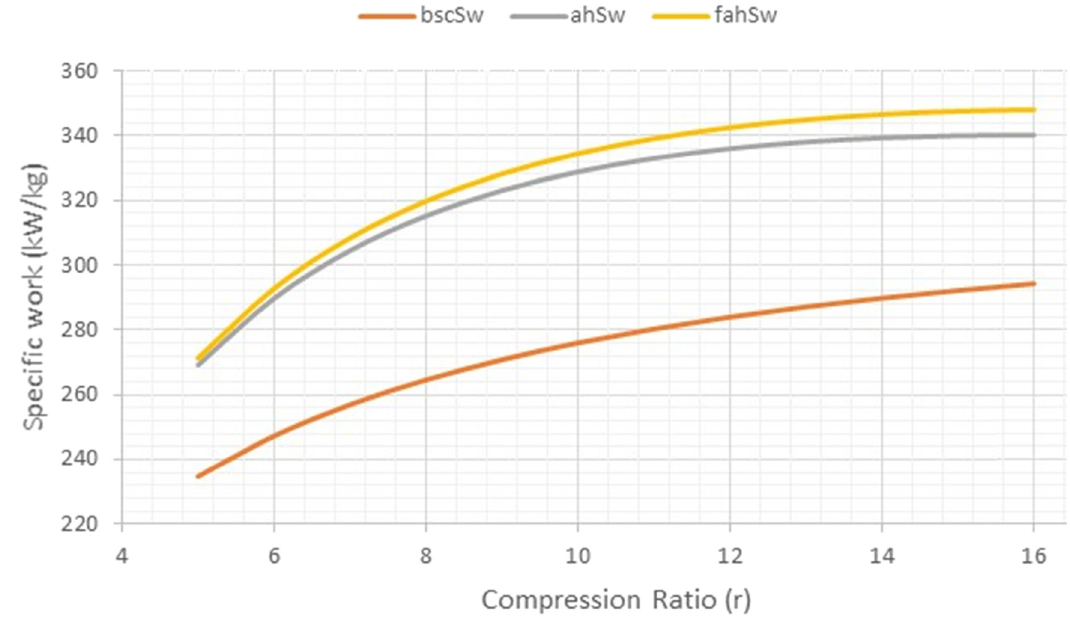
Figure 11: Variation of the speci fi c work with the compression ratio ( r ) for bsc, ah and fah cogeneration plants.